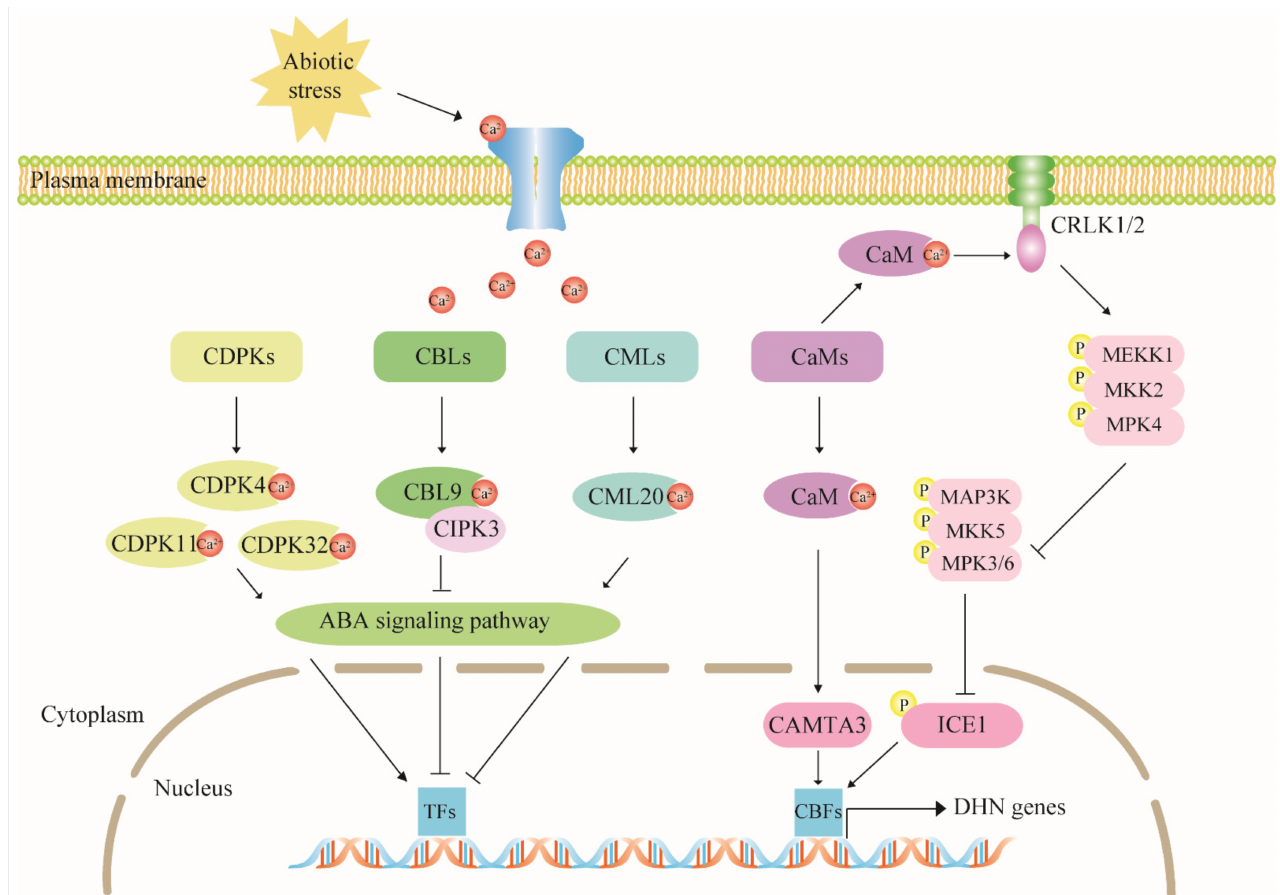
Figure 3. The calcium signal pathway has a wide range of regulatory effects on dehydrin expression. Sensors in the plasma membrane are stimulated by abiotic stress and promote the production of the secondary messenger Ca 2+ . Changes in calcium concentration are perceived by the calcium sensor proteins CDPKs, CBLs, CMLs, and CaMs. The latter either participate in the ABA signaling pathway or initiate phosphorylation/dephosphorylation cascade reactions of TFs such as CAMTAs and CBFs that eventually participate in dehydrin gene activation. CRLK1/2 regulates COR in the upstream of the MEKK1-MKK2-MPK4 cascade pathway. We use arrows and bars showing positive and negative adjustment,